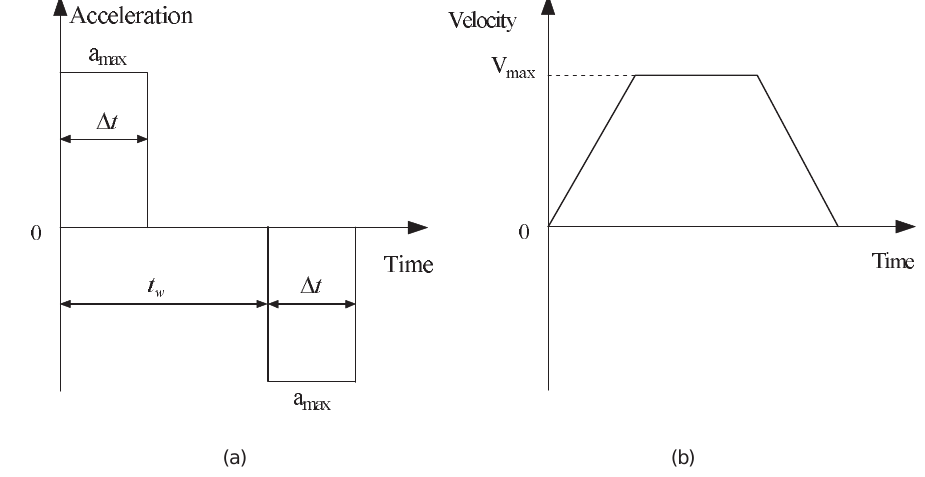
Fig. 5. Typical optimal-time trajectory: (a) acceleration profile and (b) velocity